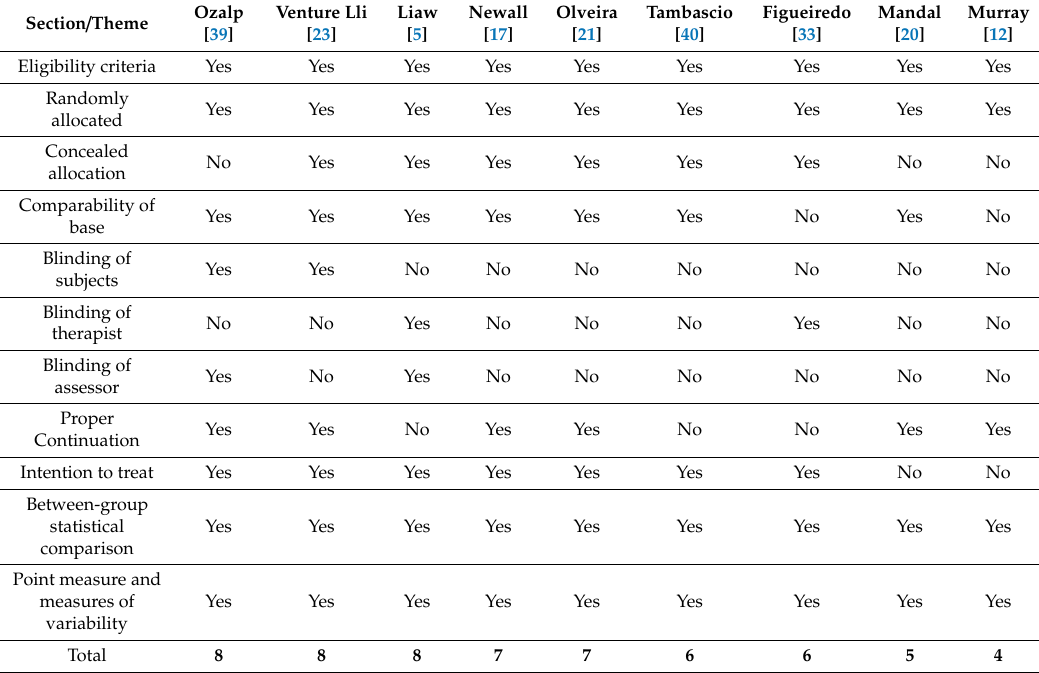
Figure 1. PRISMA flow chart of the study screening and selection process. Table 1. PEDro score for Methodological Quality assessment of nine studies.